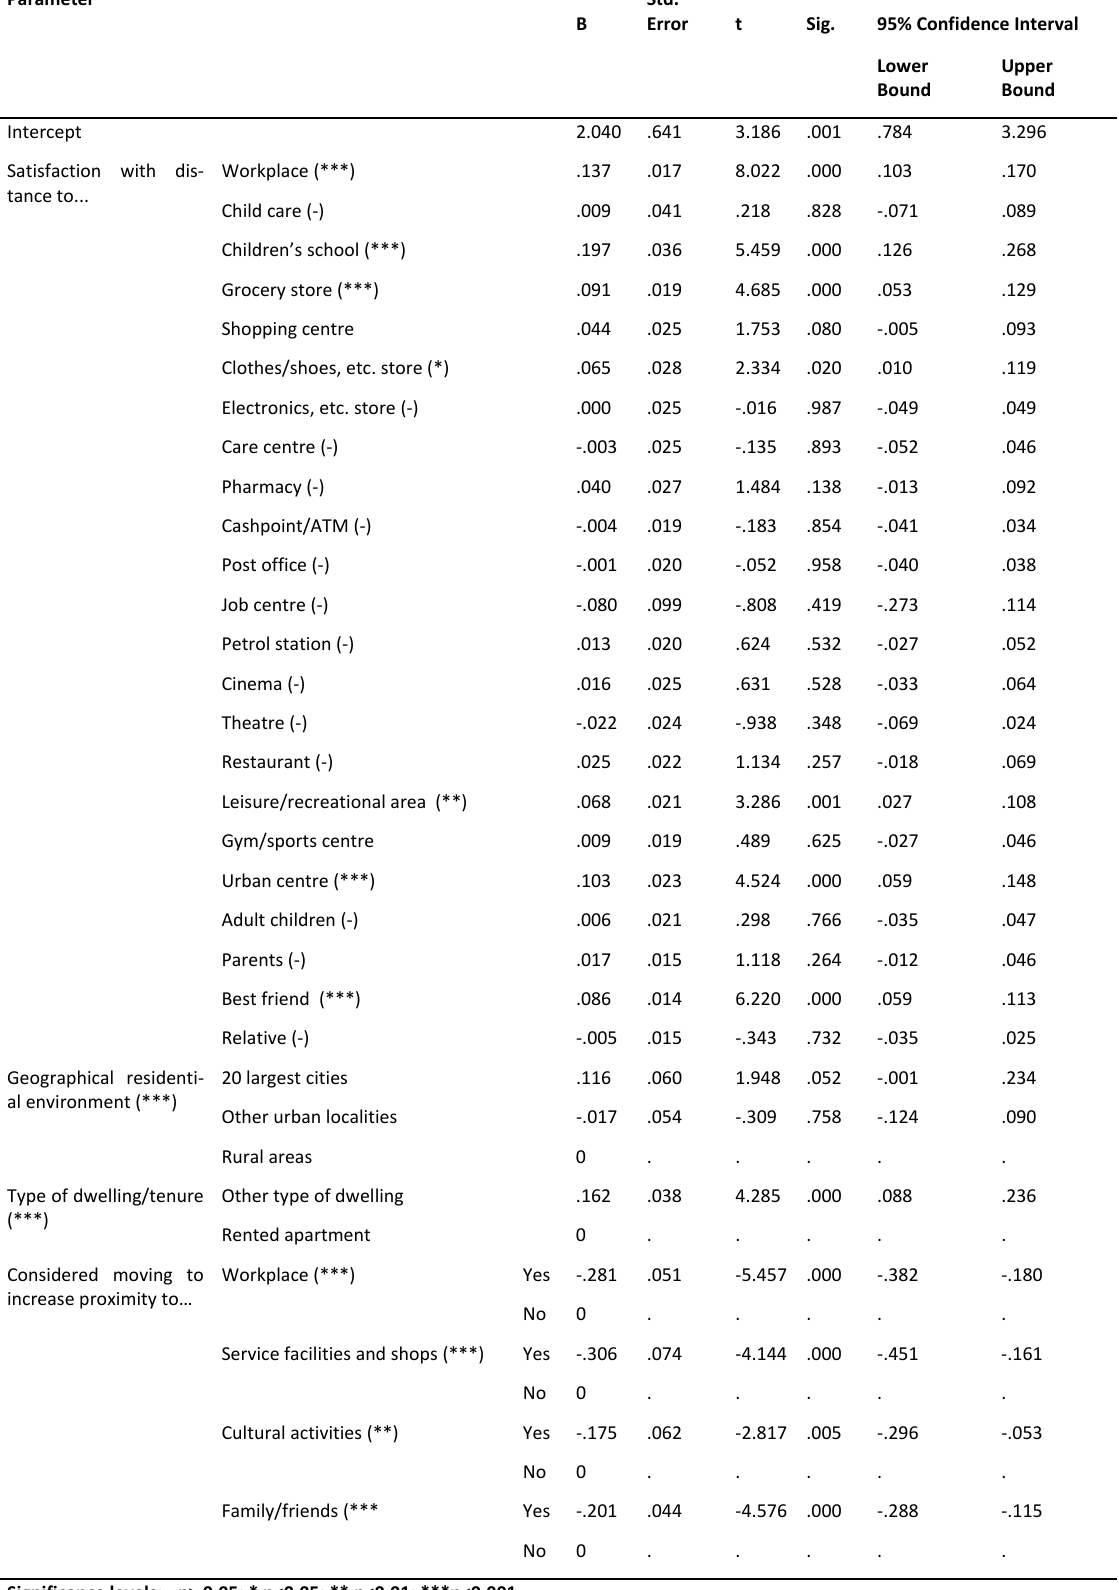
Table 2. OLS regression results Parameter